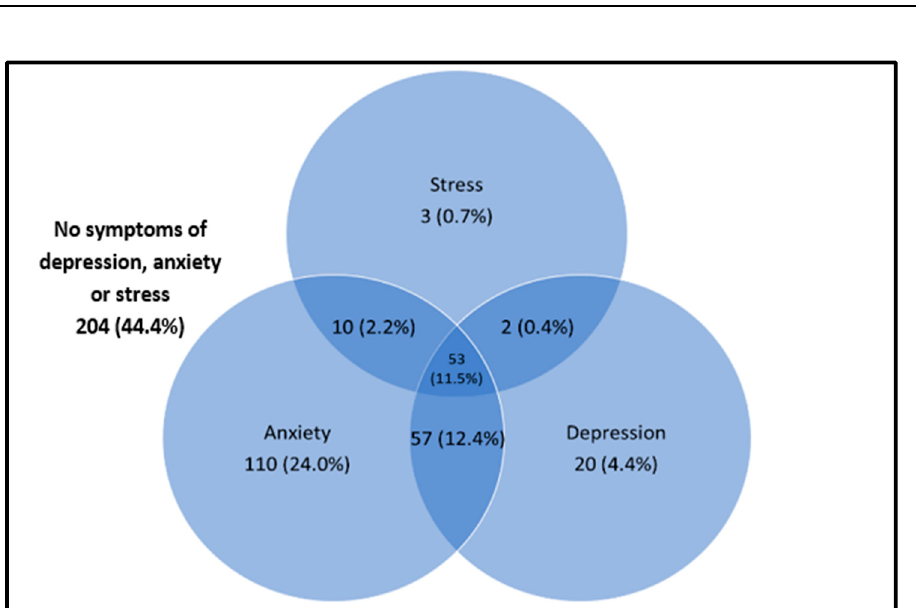
Figure 1. Coexistence of symptoms of depression, anxiety, and stress ( n = 459).